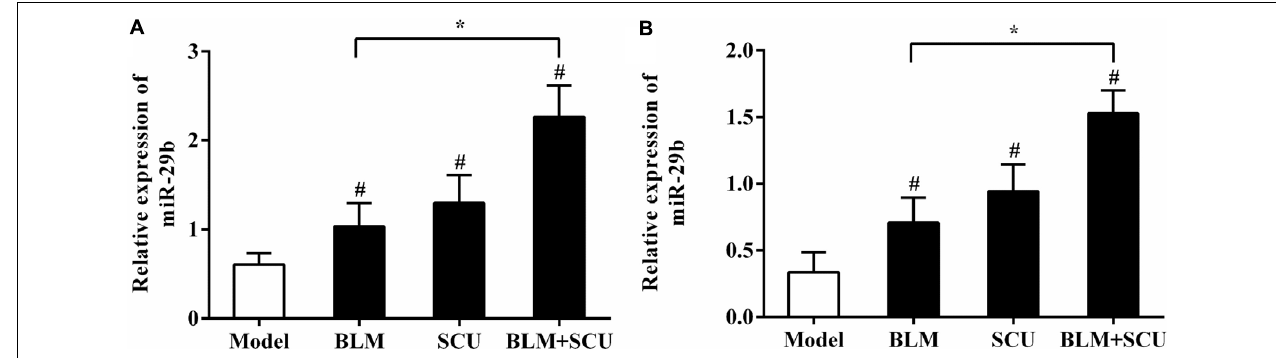
FIGURE 11 | Effects of BLM, SCU, and BLM + SCU on the miR-29b levels in the lung tissues (A) and ascetic cells (B) . The miR-29b levels was detected by real-time quantitative PCR. Data are shown as the mean ± SD. ( n = 4). # p < 0.05 compared with model group; ∗ p < 0.05 compared with BLM group.